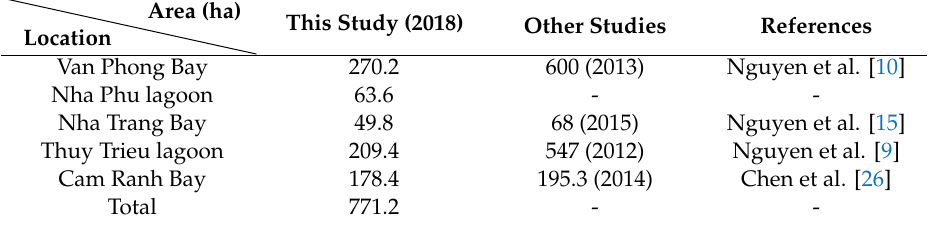
Table11. ComparisonofSAVdistributioninKhanhHoacoastalobtainedinthisstudywiththeliterature. Area (ha) This Study (2018) Other Location